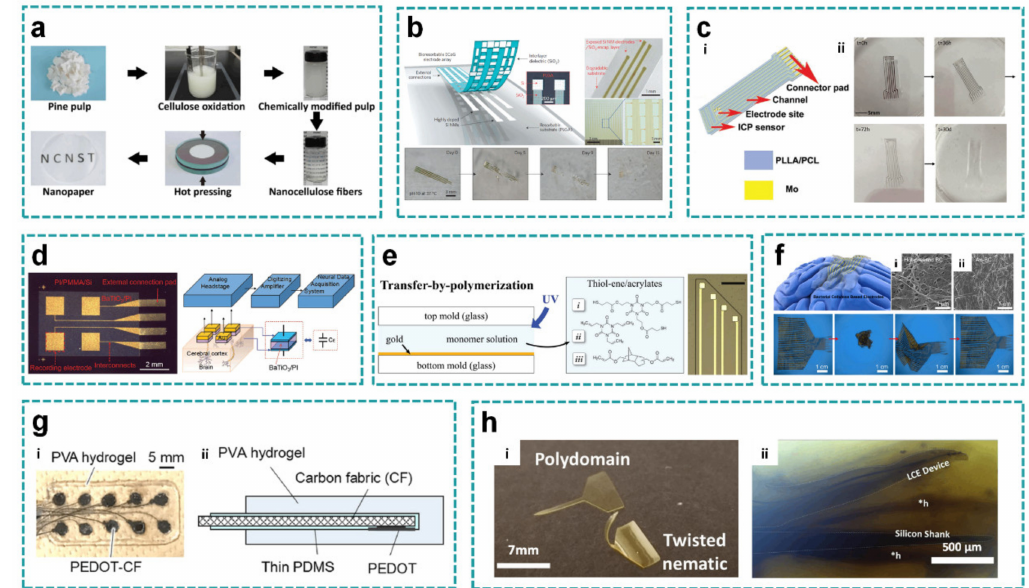
Figure 7. Special substrates. ( a ) a flexible neural electrode array based on hot-pressed nanopaper substrate (reprinted with permission from [104]); ( b ) a passive, bioresorbable neural electrode array using a film of SiO 2 and a foil of poly(lactic-co- glycolic acid) (PLGA) for ECoG and subdermal EEG measurements (reprinted with permission from [79]); ( c ) a bioabsorbable ECoG device using poly(l-lactide) (PLLA) and polycaprolactone (PCL) composite which can degrade slowly in biological fluid until it disappears completely (reprinted with permission from [105]); ( d ) the capacitive BaTiO 3 /PI electrode array (reprinted with permission from [106]); ( e ) softening substrates for neural recording electrodes with the ternary thiol- ene/acrylate shape memory polymer networks (scale bar, 60 µ m; reprinted with permission from [107]); ( f ) supersoft multichannel electrodes by depositing gold layers on thin bacterial cellulose (reprinted with permission from [78]); ( g ) a totally soft organic subdural electrode by hydrogel substrate (reprinted with permission from [108]); ( h ) LCE-based deployable intracortical microelectrode arrays (MEAs) (scale bar, 7mm in left and 500 µ m in right; reprinted with permission from